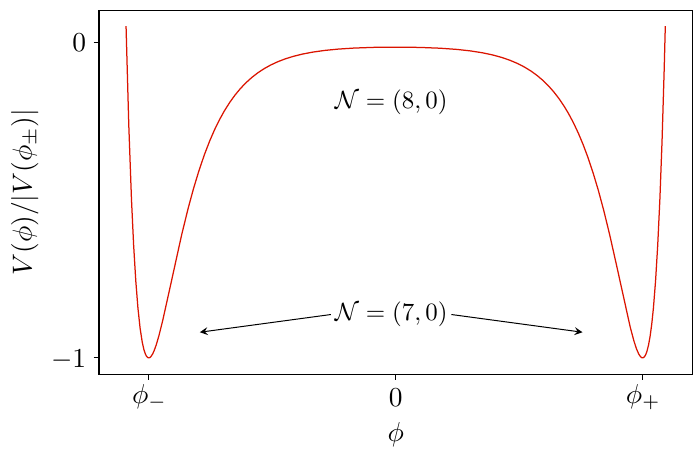
Figure 2. Potential for the 1-scalar truncation (5.12) of the theory with gauge group SO(7) The vacuum at the scalar origin (cid:30) = 0 preserves full (cid:0) (cid:1) vacua at (cid:30) = ln 3 2 p 2 spontaneously break supersymmetry down to (cid:6) (cid:6)